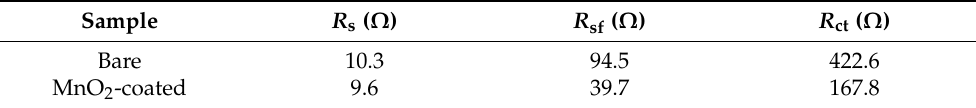
Table 4. Lattice-fitted values of the parameters according to the equivalent circuit.